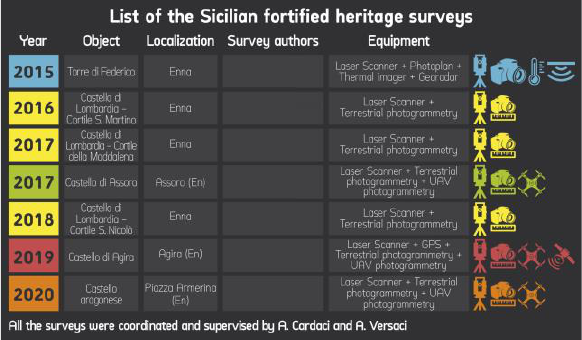
Figure 2. Chronological list of the fortified heritage surveys carried out in the province of Enna with the description of the instruments